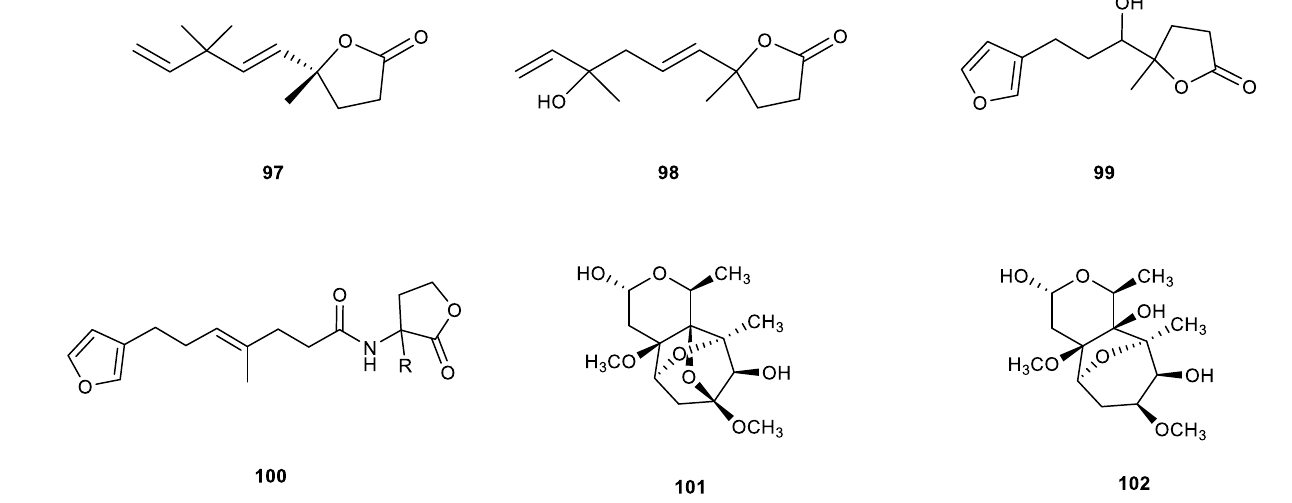
Figure 9. Other 11,12,13-tri- nor